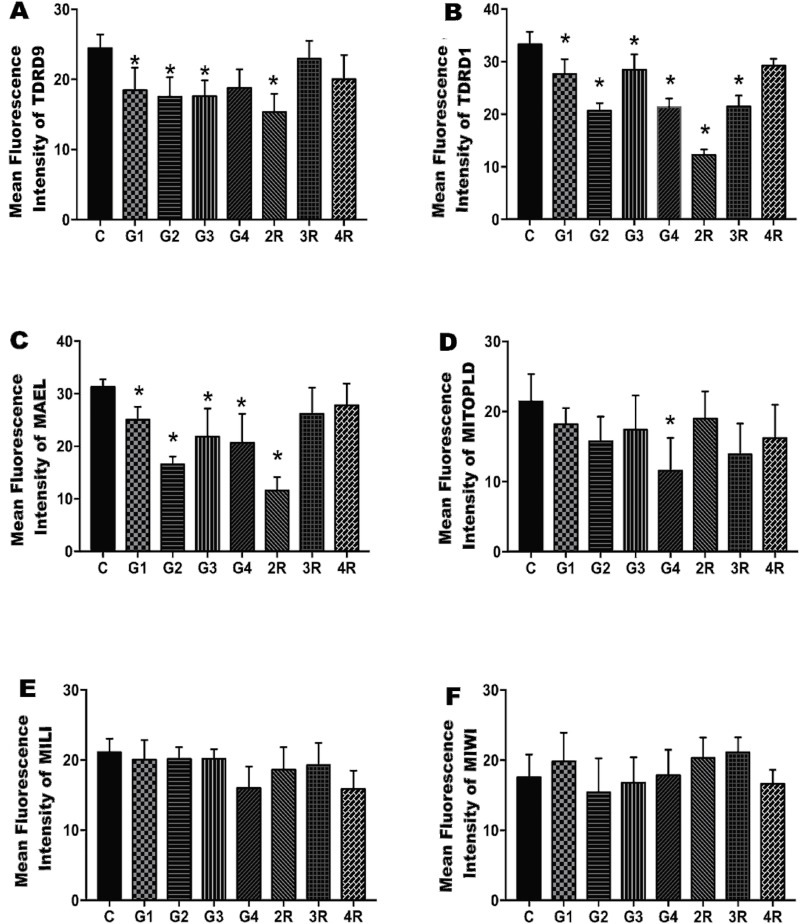
The intensity of immunoexpression of TDRD9, TDRD1, MAEL, MITOPLD, MILI, and MIWI in the ovarian tissue sections of the study groups.Comparison of the expression of TDRD9 (A), TDRD1 (B), MAEL (C), MITOPLD (D), MILI (E), and MIWI (F) in the ovarian tissue between the control and the study groups. Data are presented as the mean ± SD. C, Control; G, Group.*p<0.05.